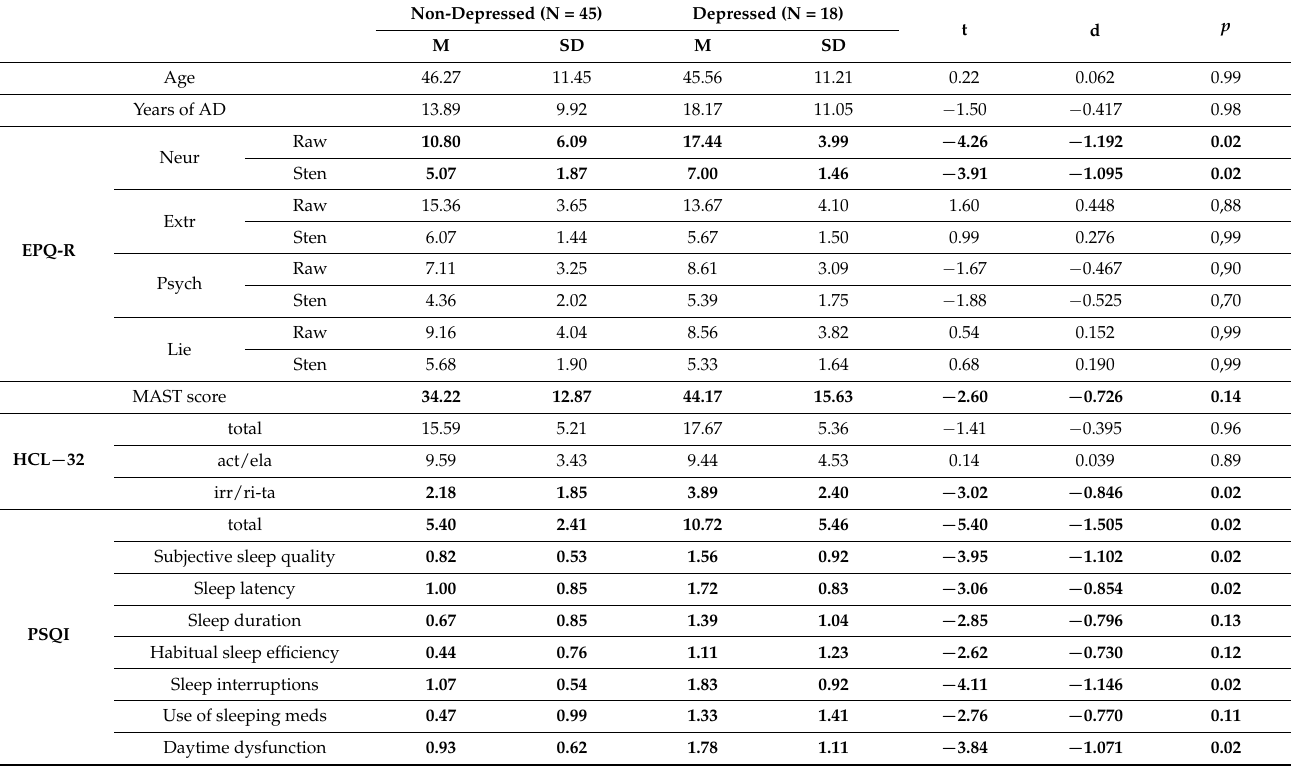
Table 3. Comparison of means (M) and standard deviations (SD) in EPQ-P, MAST, HCL-32 and PSQI questionnaires between patients with AD and depression (N = 18) and without depression (N = 45). This division was based on a BDI cut-off value of